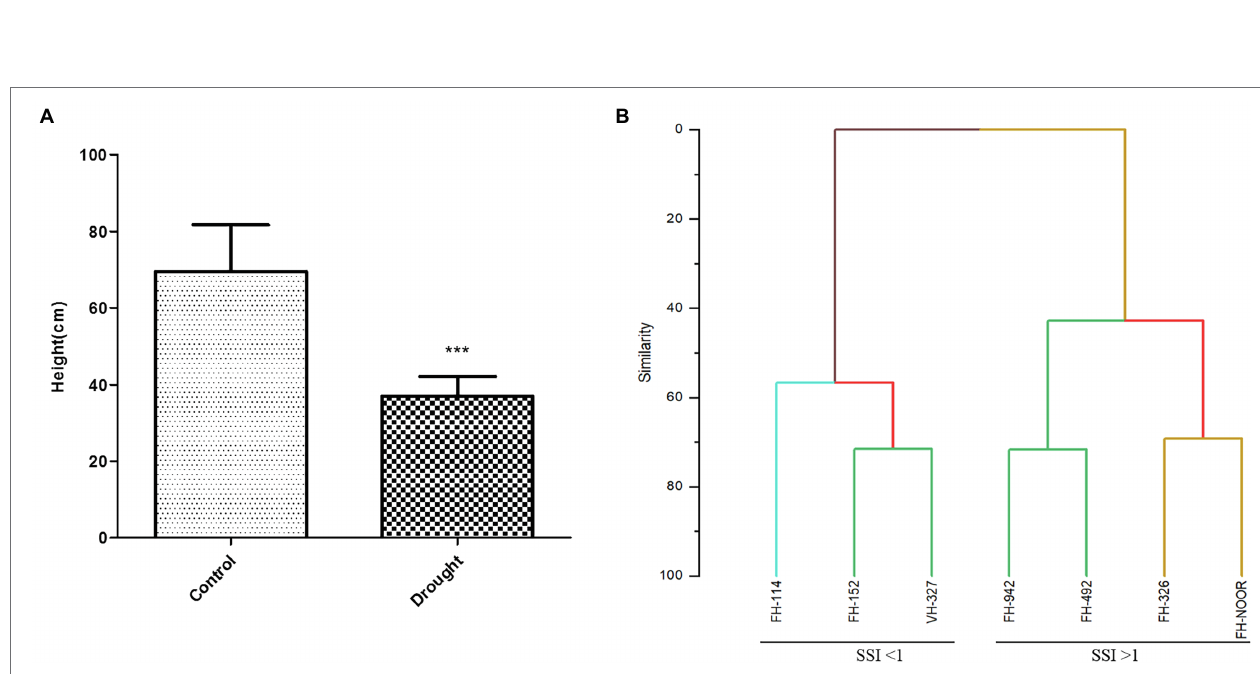
FIGURE 1 | Effect of water scarcity on the phenomics of seven cultivated varieties of Gossypium hirsutum. The shown plant is the representative of all